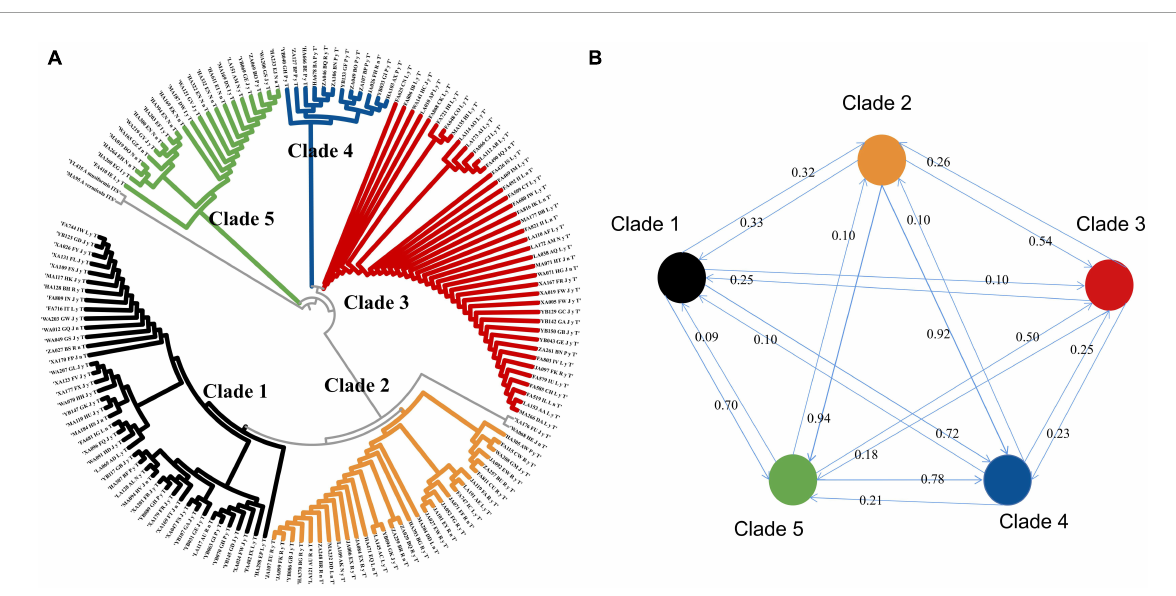
FIGURE3 (A) Phylogenetic tree of A. oligospora . (B) Gene flow among the five clades of the A. oligospora